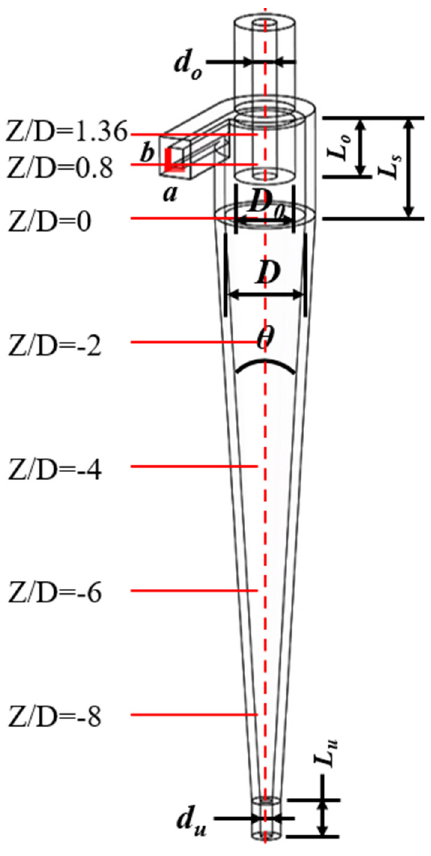
Figure 1. Structure figure of mini-hydrocyclone.